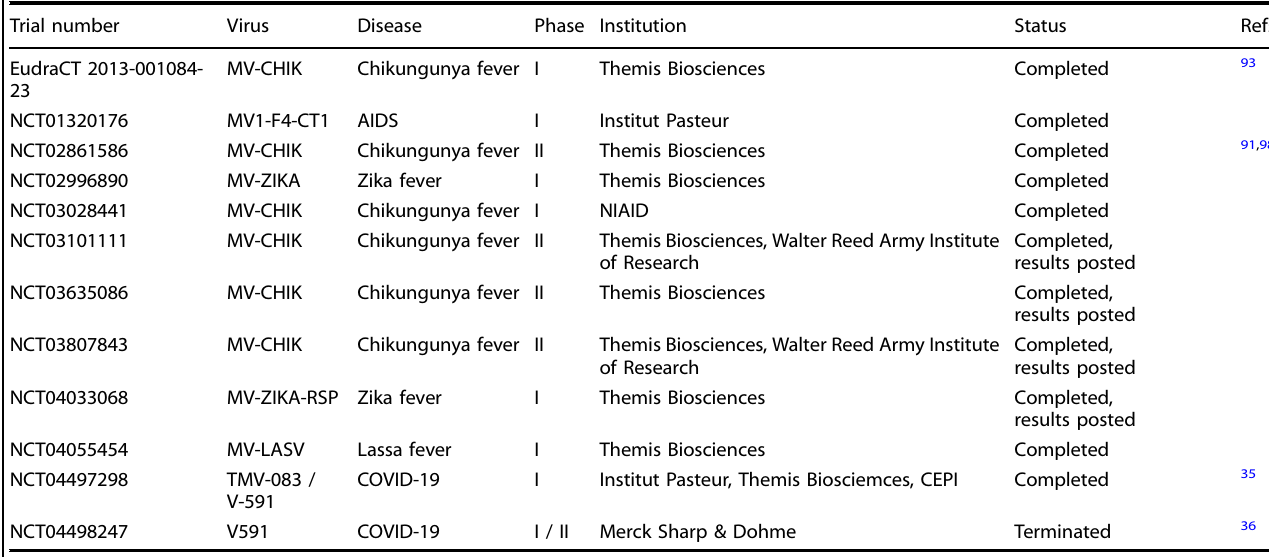
Table 3. Clincial Trials testing Live-attenuated MeV-derived vaccines. Trial number